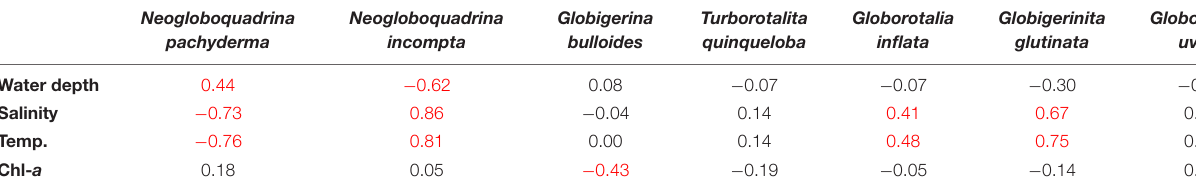
TABLE 1 | Correlation factors for the relative abundance of planktic foraminifera ( Neogloboquadrina pachyderma , Neogloboquadrina incompta , Globigerina bulloides , Turborotalita quinqueloba , Globorotalia inflata , Globigerinita glutinata , and Globigerinita uvula ) with different environmental parameters [average temperature (Temp., ◦ C) and salinity (PSU) of the first 100 m of the water column, Chlorophyll- a (Chl- a , mg m − 3 ) and water depth (m)].